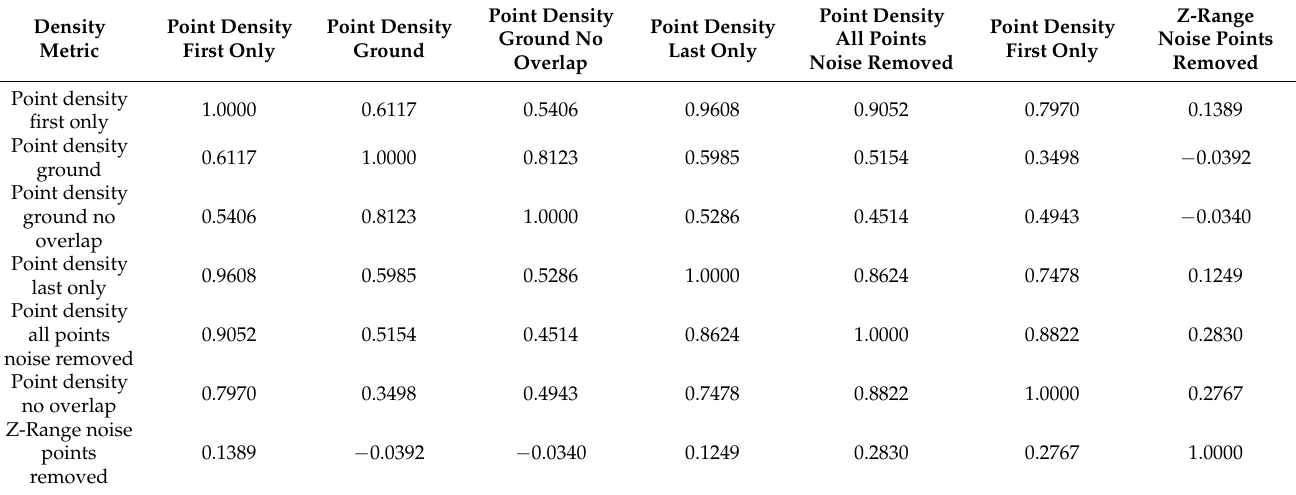
Table 6. Multivariate correlations of density metrics for complete random sample